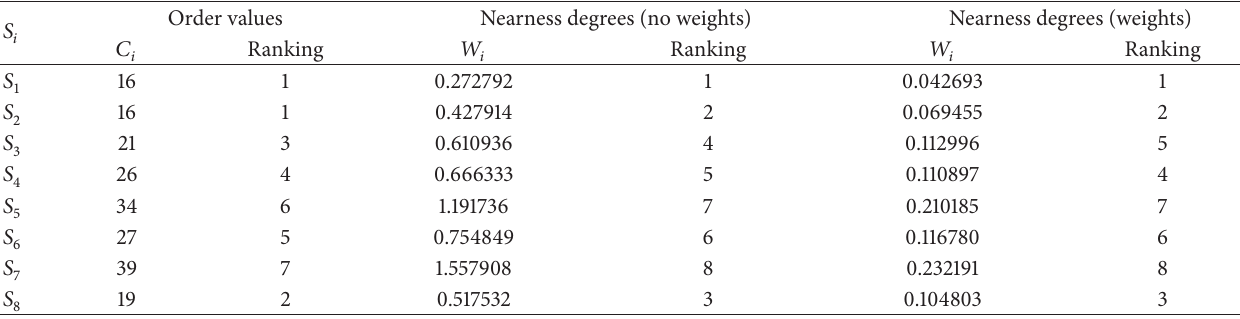
Table 7: Alternatives ranking with two types of method.